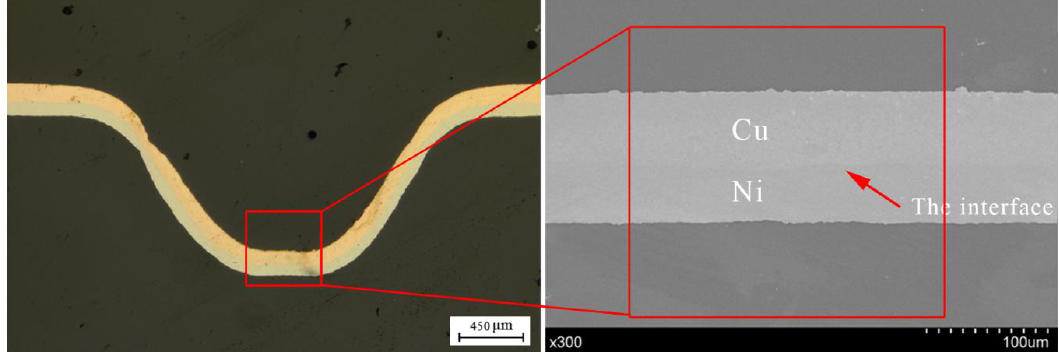
Figure 24. The position of the interface measured by SEM.